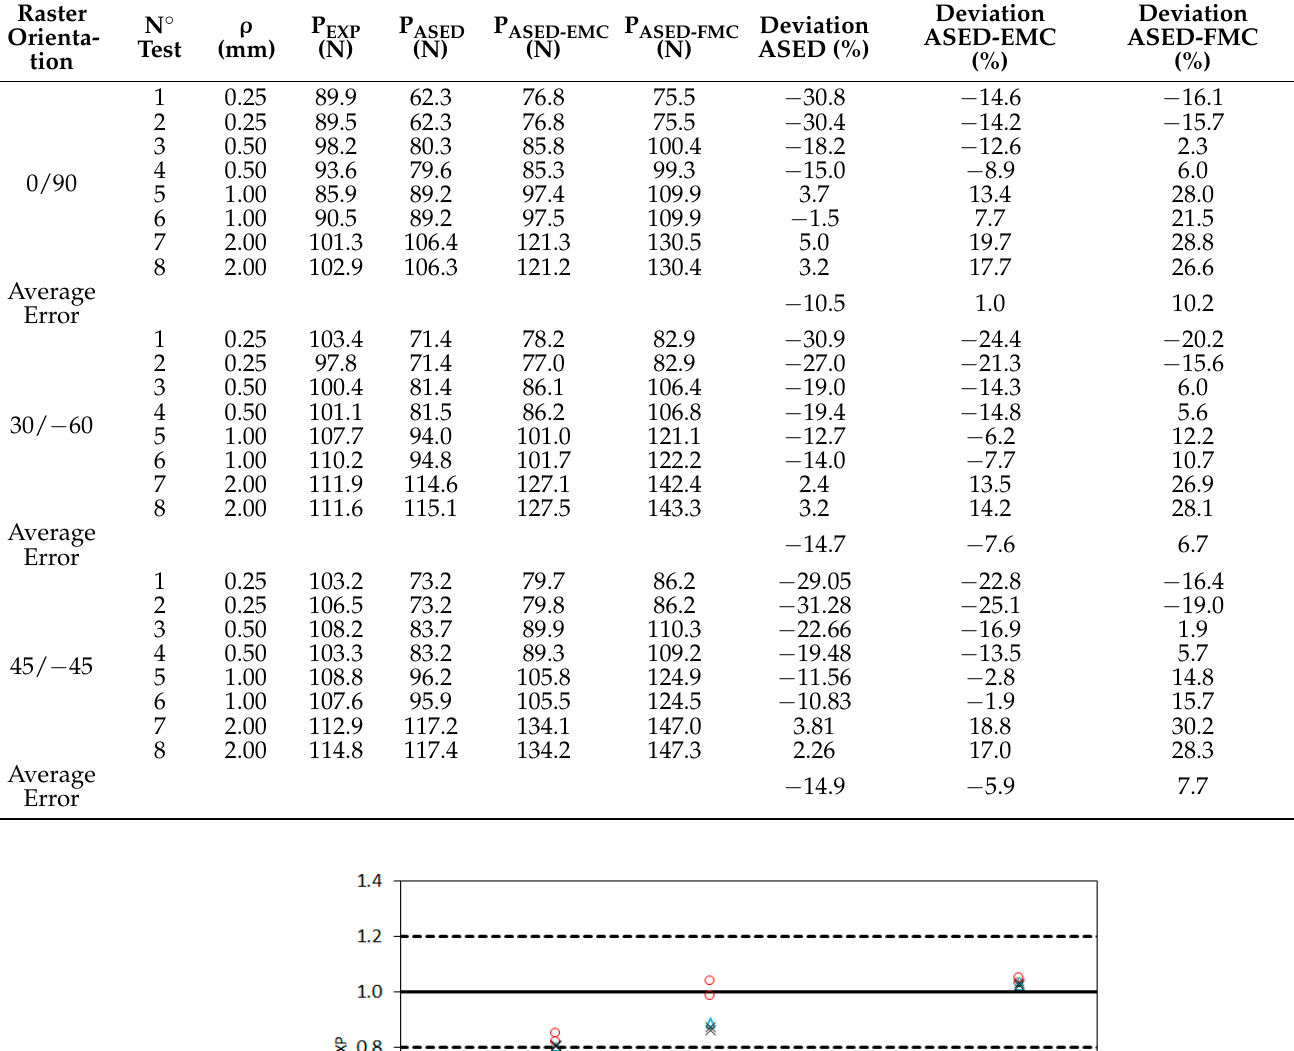
Table 4. Experimental critical loads (P exp ) of the fracture specimens along with the predictions obtained using ASED, ASED-EMC and ASED-FMC approaches.